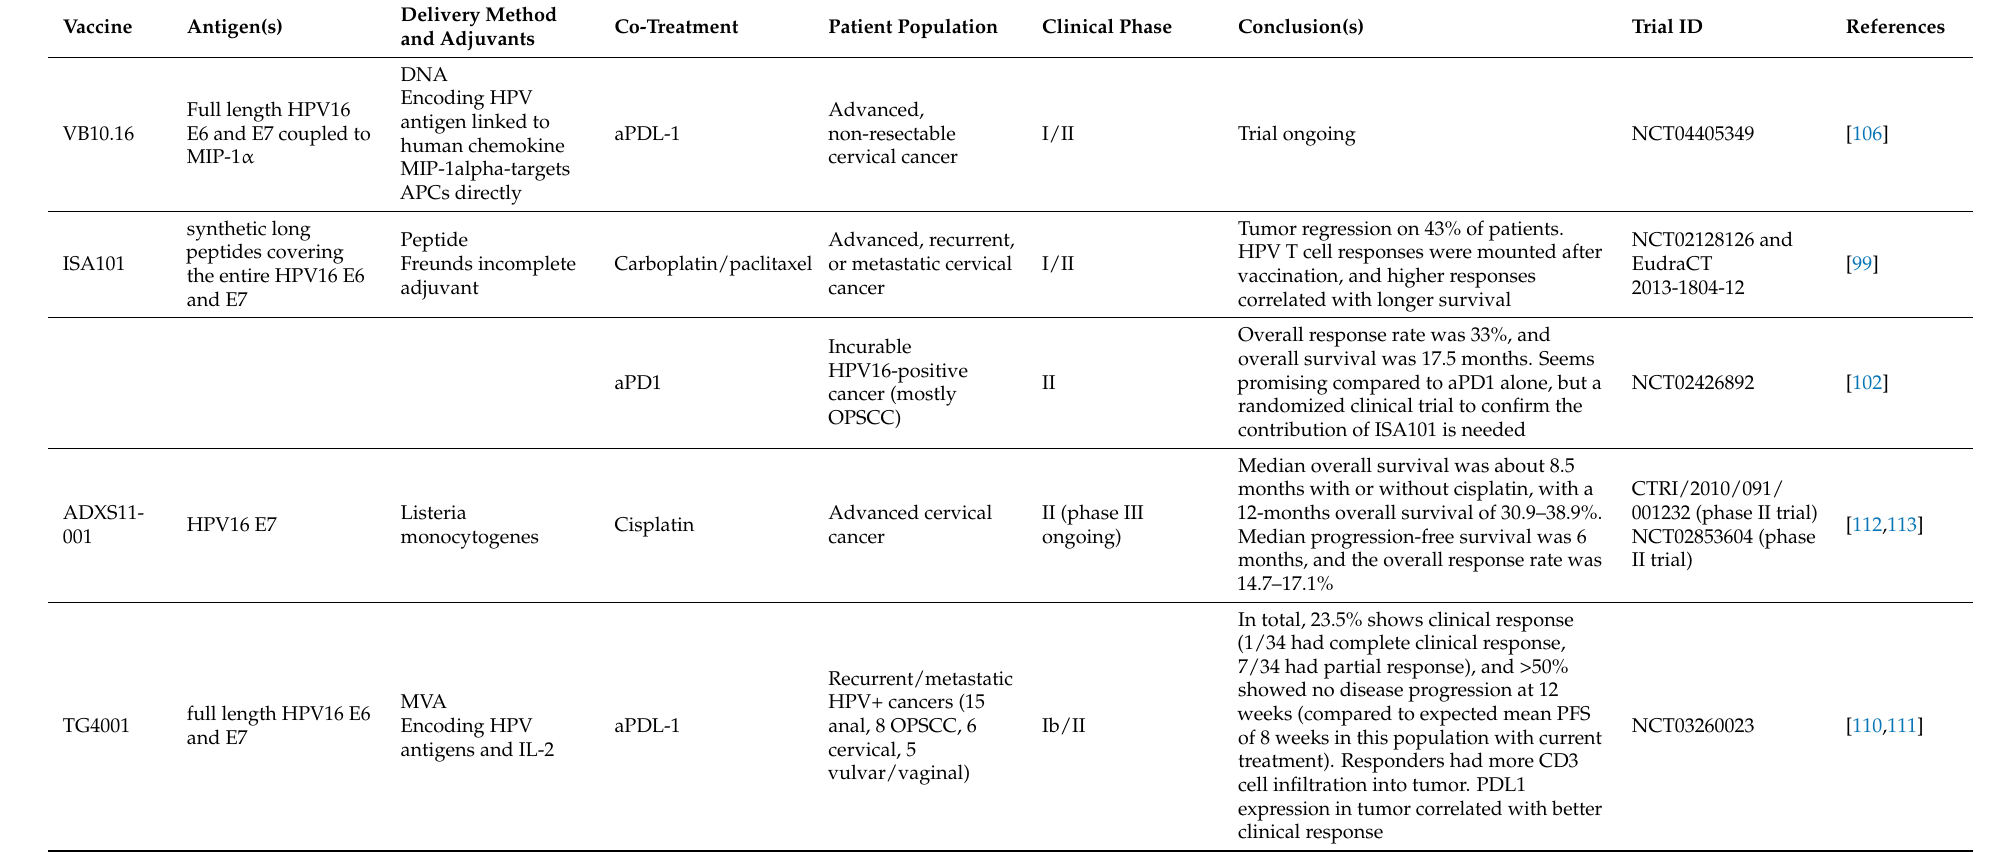
Table 2. Summary of recent clinical trials of HPV therapeutic vaccines against HPV+